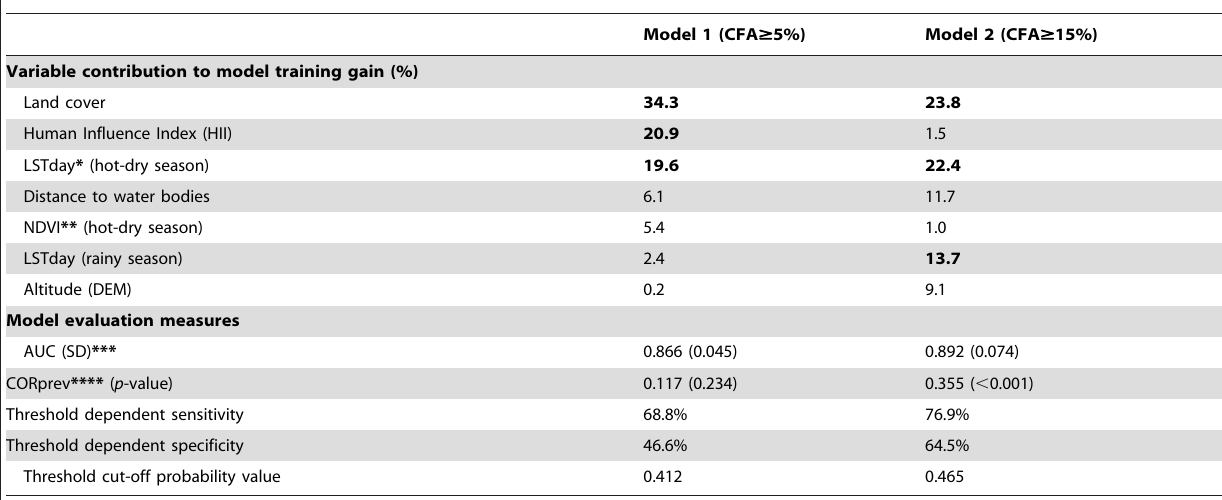
Table 3. Summary statistics of jackknife test of environmental variable importance, evaluation measures, and maximum training sensitivity plus specificity threshold results for MaxEnt model 1 (sites with CFA $ 5%) and model 2 (sites with CFA prevalence $